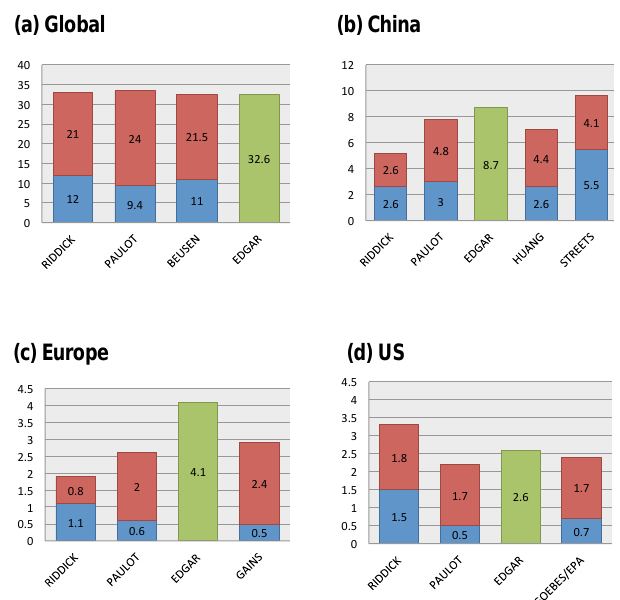
Figure 11. Comparison of manure (red) and synthetic fertilizer (blue) NH 3 emissions or combined manure and synthetic fertilizer emissions (green) (TgNyr − 1 ) for various inventories (see text for details) and regions: (a) global, (b) China, (c) Europe and (d) US. Emissions from this study are labeled as